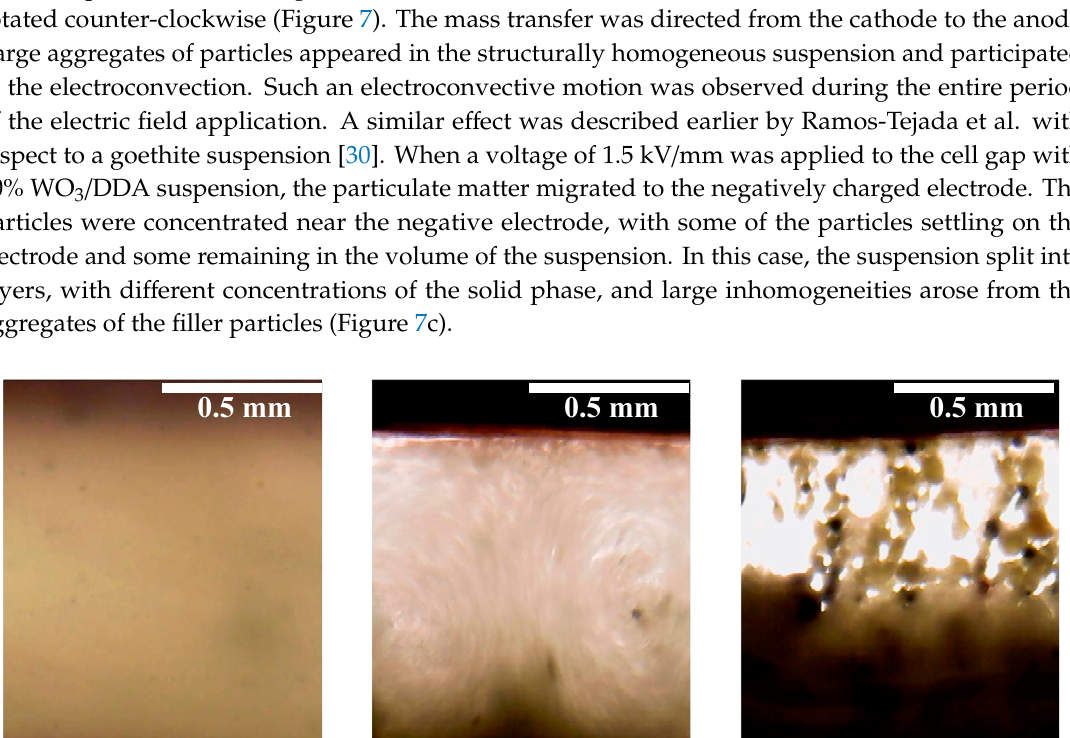
Figure 8. Dependence of ( a ) shear stress and ( b ) dynamic viscosity of the electrorheological fluid containing 60 wt% WO 3 on the electric field strength, at different shear rates.